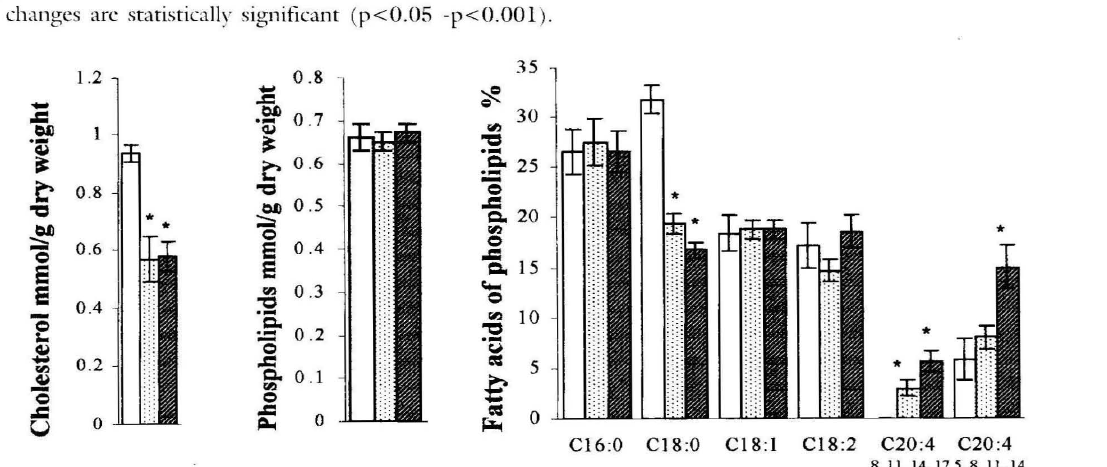
Figure 9. Concentrations (mean±S.D.) of cholesterol and phospholipids as well as fltty acid content of phospholipids (in percent; mean±S.D.) in controls (open bars) and in samples with 5 pmol/g wet weight 5,6,7,8-tetrahydrobiopterin (dotted bars) and in samples with 30 pmol/g wet weight 5,6,7,8-tetrahvdrobiopterin (lutched bars). Samples of rat liver tissue homogenates wel'e used to test for phospholipid biosvnthesis ill I·if/n. Incubation medium: Krebs - Ringer phosphate bufrer containing 0.3% albumin (pH= 7.4), fatty acid mixnm: and glycerol. Samples were incubated twice tI:JJ. 4 h at 37 C. "The changes arc statistically significant (p